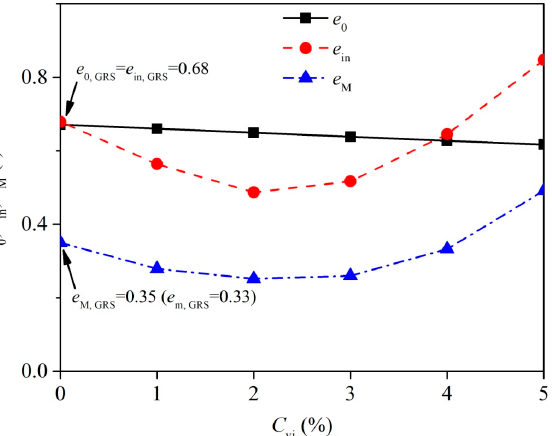
Figure 15. Delimitation of macro- and micro-pores in saturated untreated GRS based on results of an intrusion–extrusion cycle.